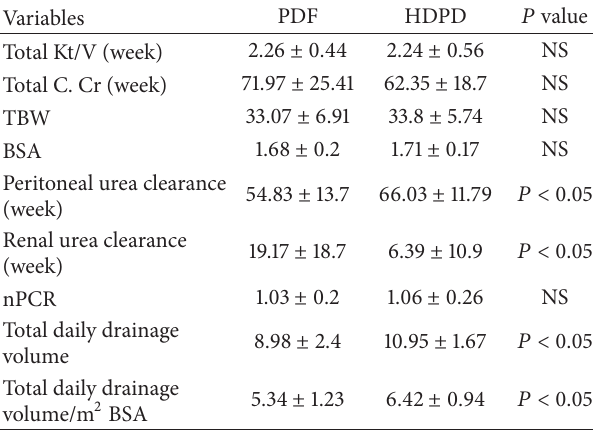
Table 2: Adequacy